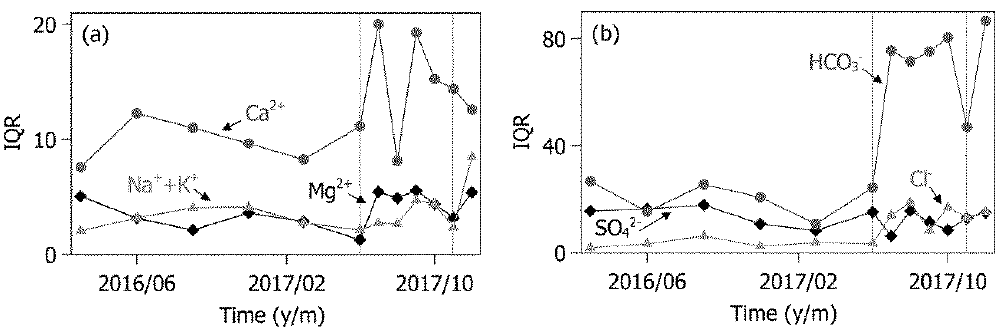
Figure 10. Variations in the interquartile ranges (IQR) of ( a ) major cations and ( b ) anions in groundwater in the area upstream of the Juksan weir, except within the oxbow lake.